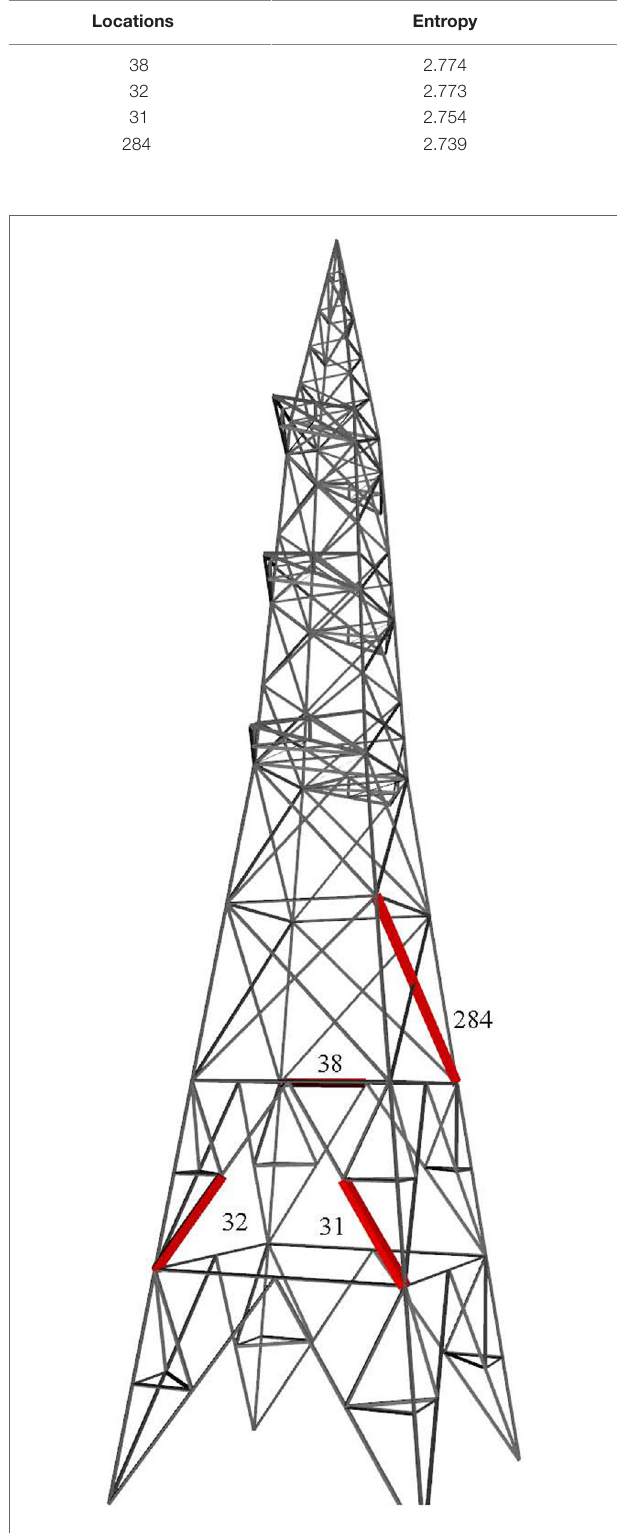
FigUre 4 | locations showing first the four highest values of entropy